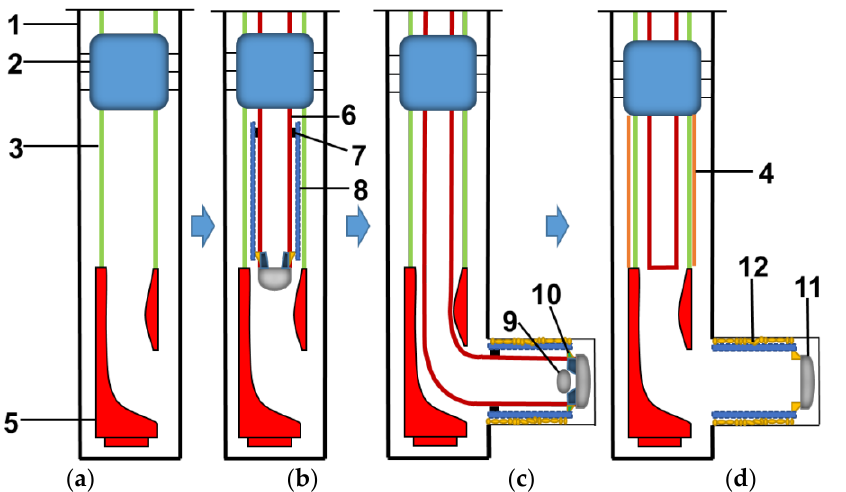
Figure 2. Integrated design of abrasive waterjet drilling radial well + liner completion. 1—Casing